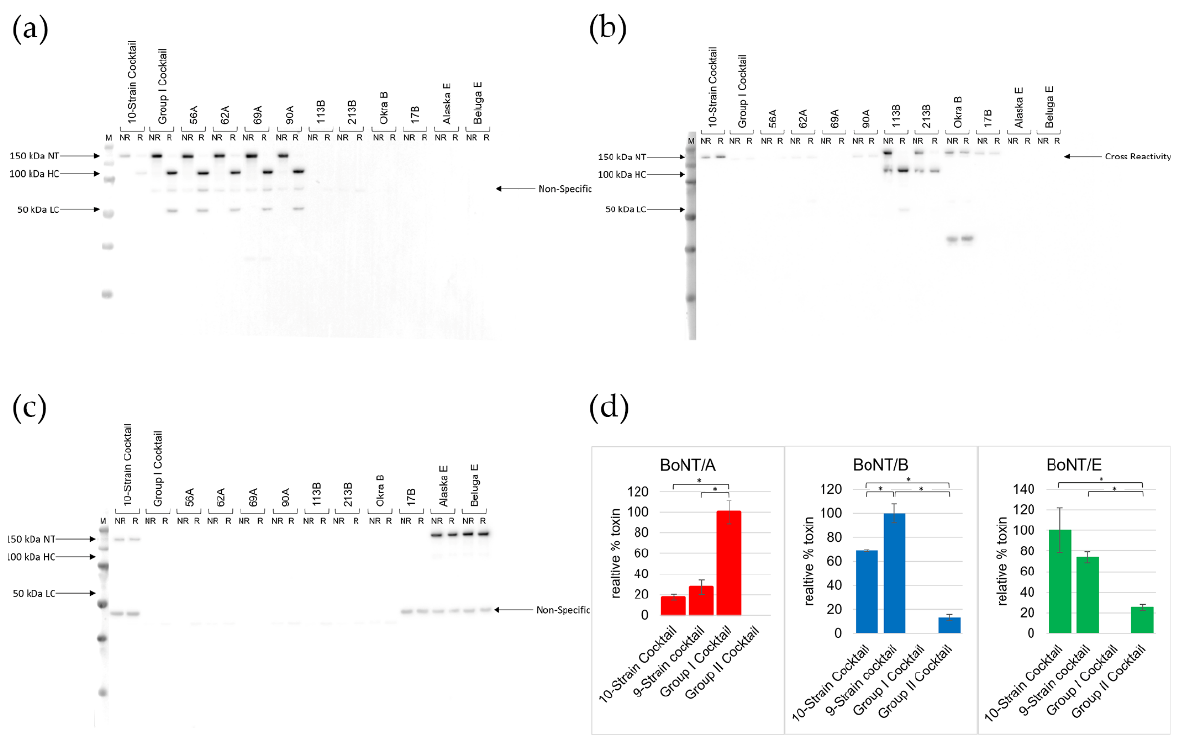
Figure 3. Toxin production by C. botulinum strain cocktails and individual strains. ( a – c ) Western blot analysis of non-reduced (NR) and reduced (R) whole culture samples alongside a molecular weight marker (M; PageRuler Plus) grown for 4 days at 30 ◦ C in TPM. The toxin type produced was detected with ( a ) BoNT/A1-specific antibody, ( b ) BoNT/B1-specific antibody, and ( c ) BoNT/E3- specific antibody. Non-specific bands can be faintly seen in each blot and, in the blots probed with antibodies specific to BoNT/B1, there appears to be cross-reactivity to the 150 kDa type A neurotoxin rather than the BoNT/B. It is this cross-reactivity that can be seen in the Group I cocktail samples on the blots probed with BoNT/B1-specific antibody. ( d ) Quantitative depiction of the relative percentage of each toxin type produced by each cocktail (n = 3). The cocktail that produced the highest amount of the given BoNT serotype was set at 100%. Asterisk (*) indicates a statistical significance with p <